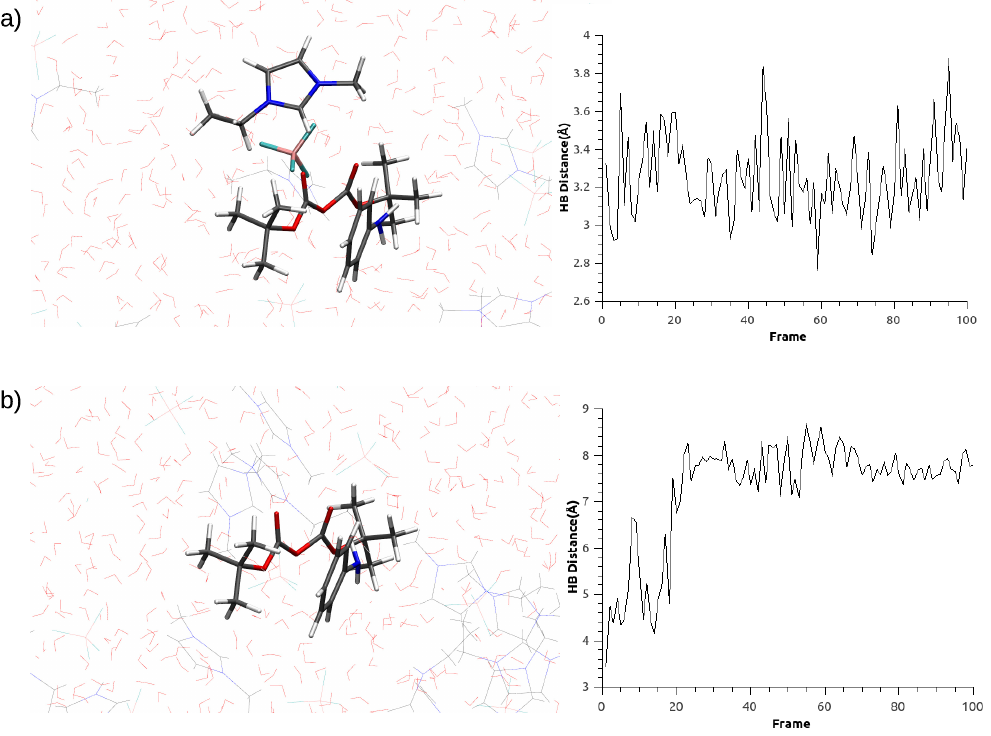
Figure 2. Comparison between the relative distance the reactants and [EMIM][BF 4 ]. ( a ) Molecular dynamics (MD) with restrain distance between reactants and [EMIM][BF 4 ]. ( b ) MD without restrain distance between reactants and [EMIM][BF 4 ]. Where colors correspond to: C–gray, O–red, N–blue, H–white, B–pink,